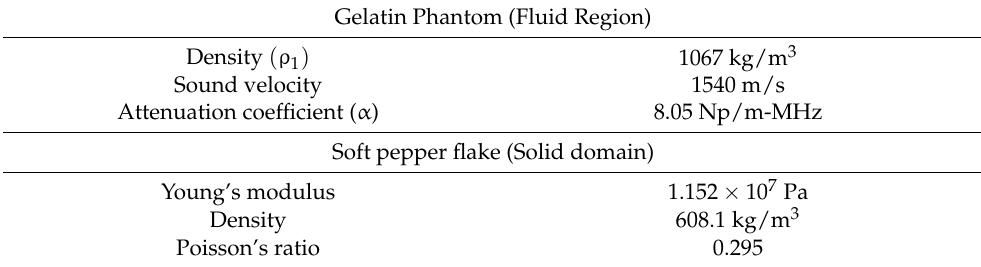
Table 1. Material